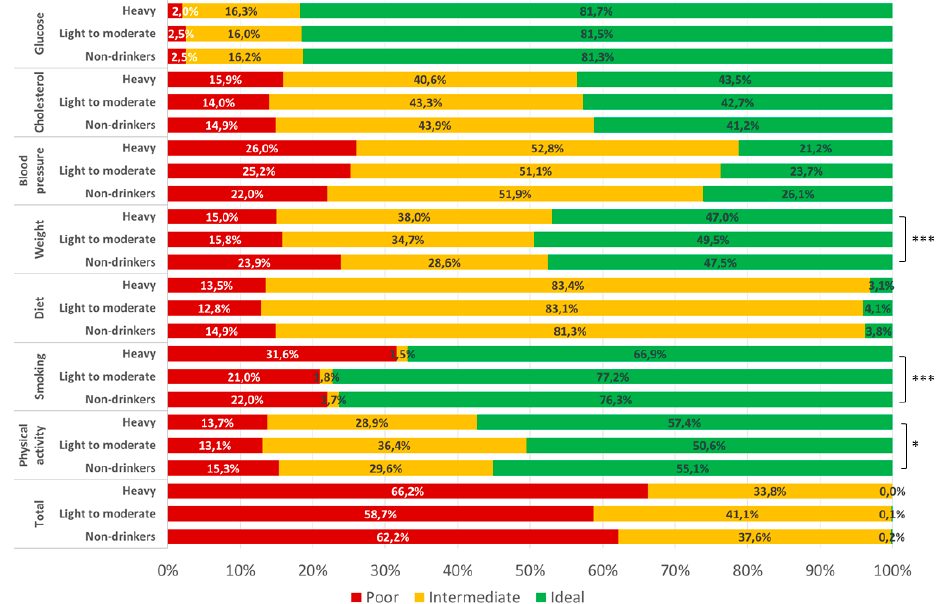
Figure 1. Distribution of cardiovascular health metrics according to drinking patterns. * p < 0.05, *** p < 0.001 based on the Chi-Squared test using non-drinkers as reference group.